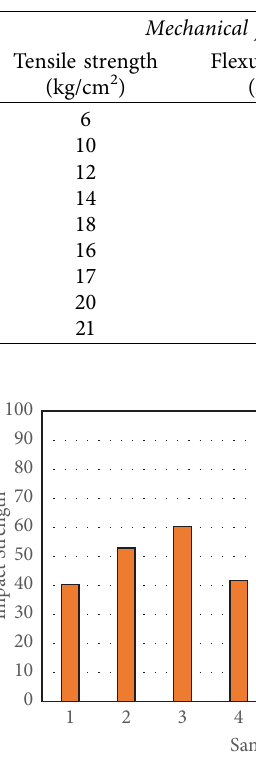
Figure 5: Variation in impact strength against the varying wt. % of natural